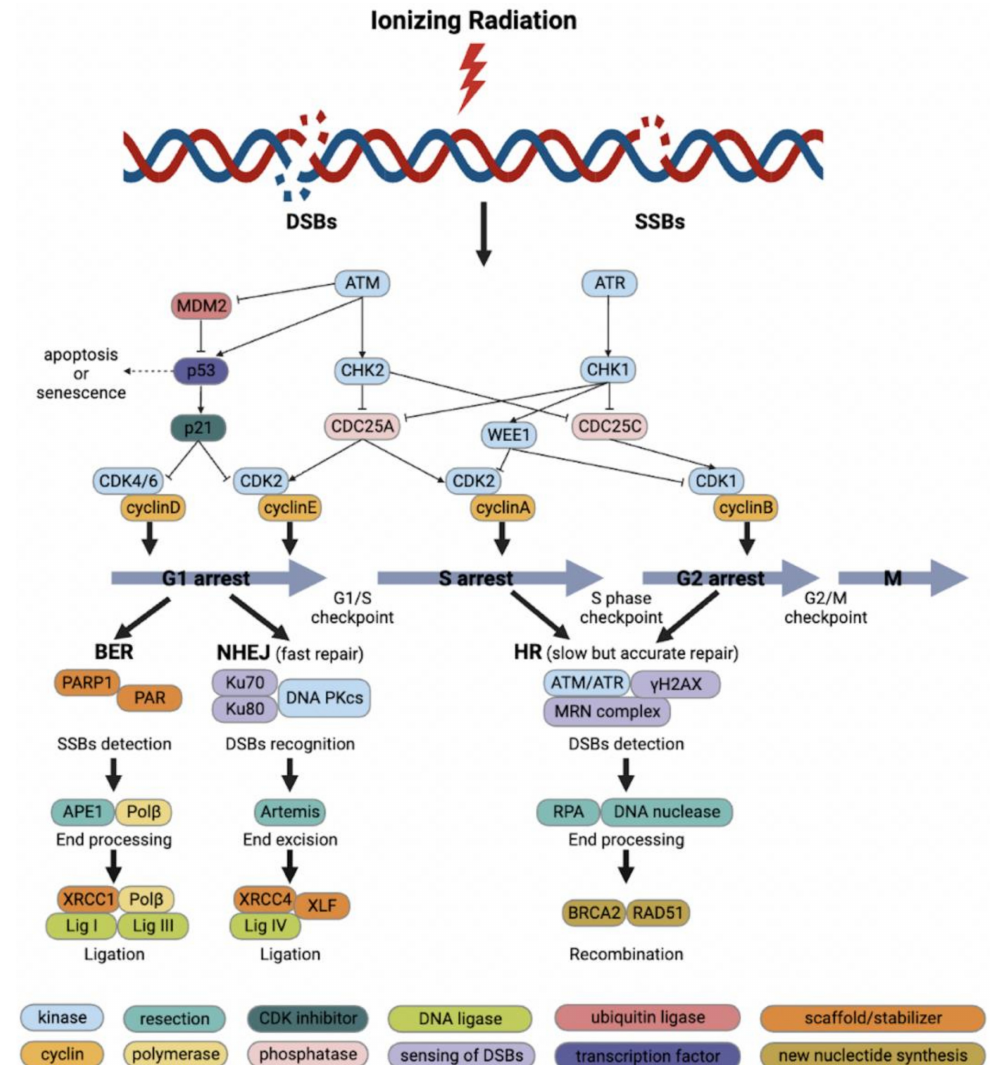
Figure 1. Schematic diagram of ionizing radiation (IR)-induced DNA damage response and DNA repair. Cell-cycle checkpoints are activated in response to IR-induced DNA damage. ATM kinase is activated primarily by DNA double-strand breaks (DSBs) and mediates the initial response to DSBs as well as cell-cycle arrest through activation of CHK2. P53 activates the G1/S checkpoint via p21 to promote DNA repair or to induce apoptosis or senescence. DNA single-strand breaks (SSBs) activate ATR kinase, which in turn activates the S-phase checkpoint and G2/M checkpoint through the action of CHK1 and WEE1. The base excision repair (BER) repairs SSBs and base damage with fast kinetics. Non-homologous end-joining (NHEJ) repairs most direct 2-ended IR-induced DSBs and is the main pathway to repair DSBs in the G1 phase. Homologous recombination (HR) is essential for the repair of complicated DSBs and can only function in the presence of sister chromatids during the S and G2